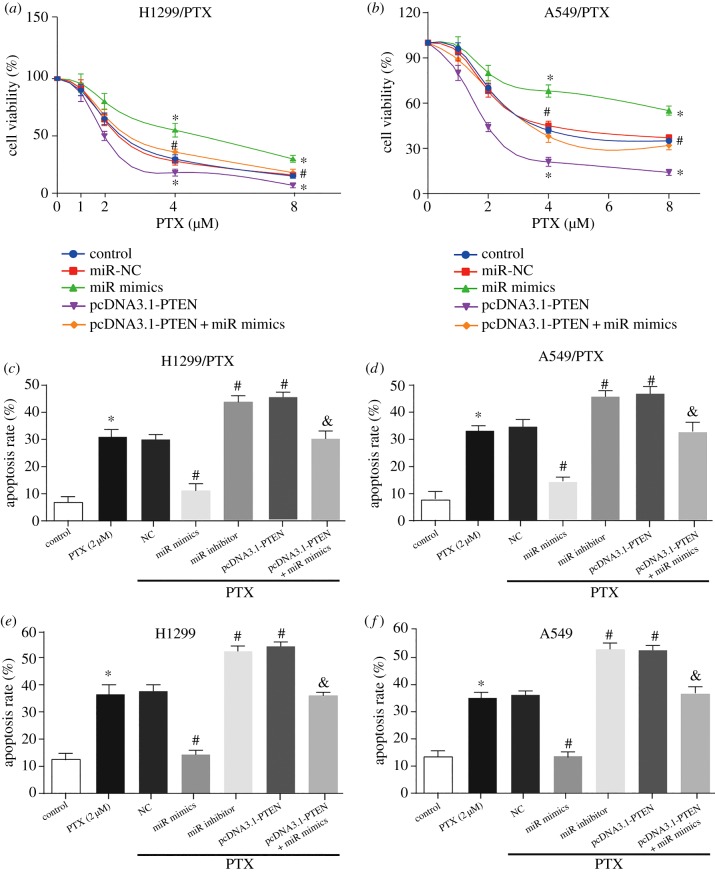
Overexpression of miR-4262 promotes PTX resistance in vitro. A549/PTX and H1299/PTX cells were transfected with pcDNA3.1-PTEN, miR-4262 mimics, pcDNA3.1-PTEN + miR-4262 mimics. (a,b) The transfected cells were treated with different concentrations of PTX, and a CCK-8 assay was employed to analyse cell viability. *p < 0.05 compared with control or miR-NC group, and #p < 0.05 compared with the pcDNA3.1-PTEN or miR-4262 mimics group. (c,d) The proportion of apoptotic cells of annexin V/PI stained in A549/PTX and H1299/PTX are shown. *p < 0.05 versus the control group; #p < 0.05 versus the PTX + NC group; &p < 0.05 versus the PTX paclitaxel + pcDNA3.1-PTEN or PTX paclitaxel + miR mimics group. (e,f) The proportion of apoptotic cells of annexin V/PI staining in A549 and H1299 are shown. *p < 0.01 versus the control group; #p < 0.05 versus the PTX + NC group; &p < 0.05 versus the PTX + pcDNA3.1-PTEN or PTX + miR mimics group.